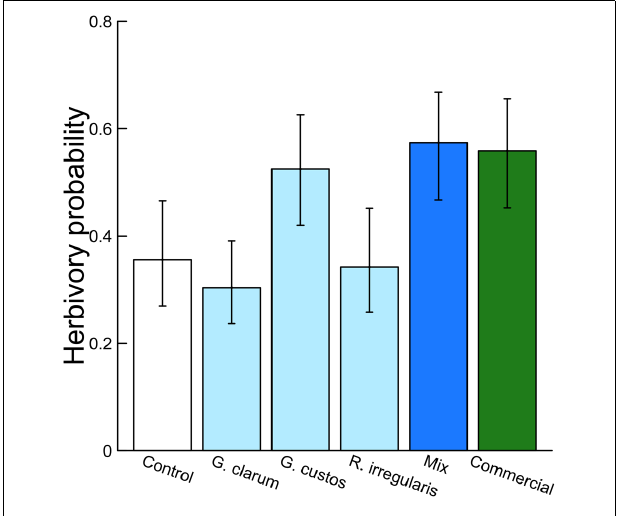
FIGURE 4 | Effects ofAMF inoculation treatments on probability of herbivore attack. Values are fitted means ± 1 SE, transformed from logits to probability for ease of